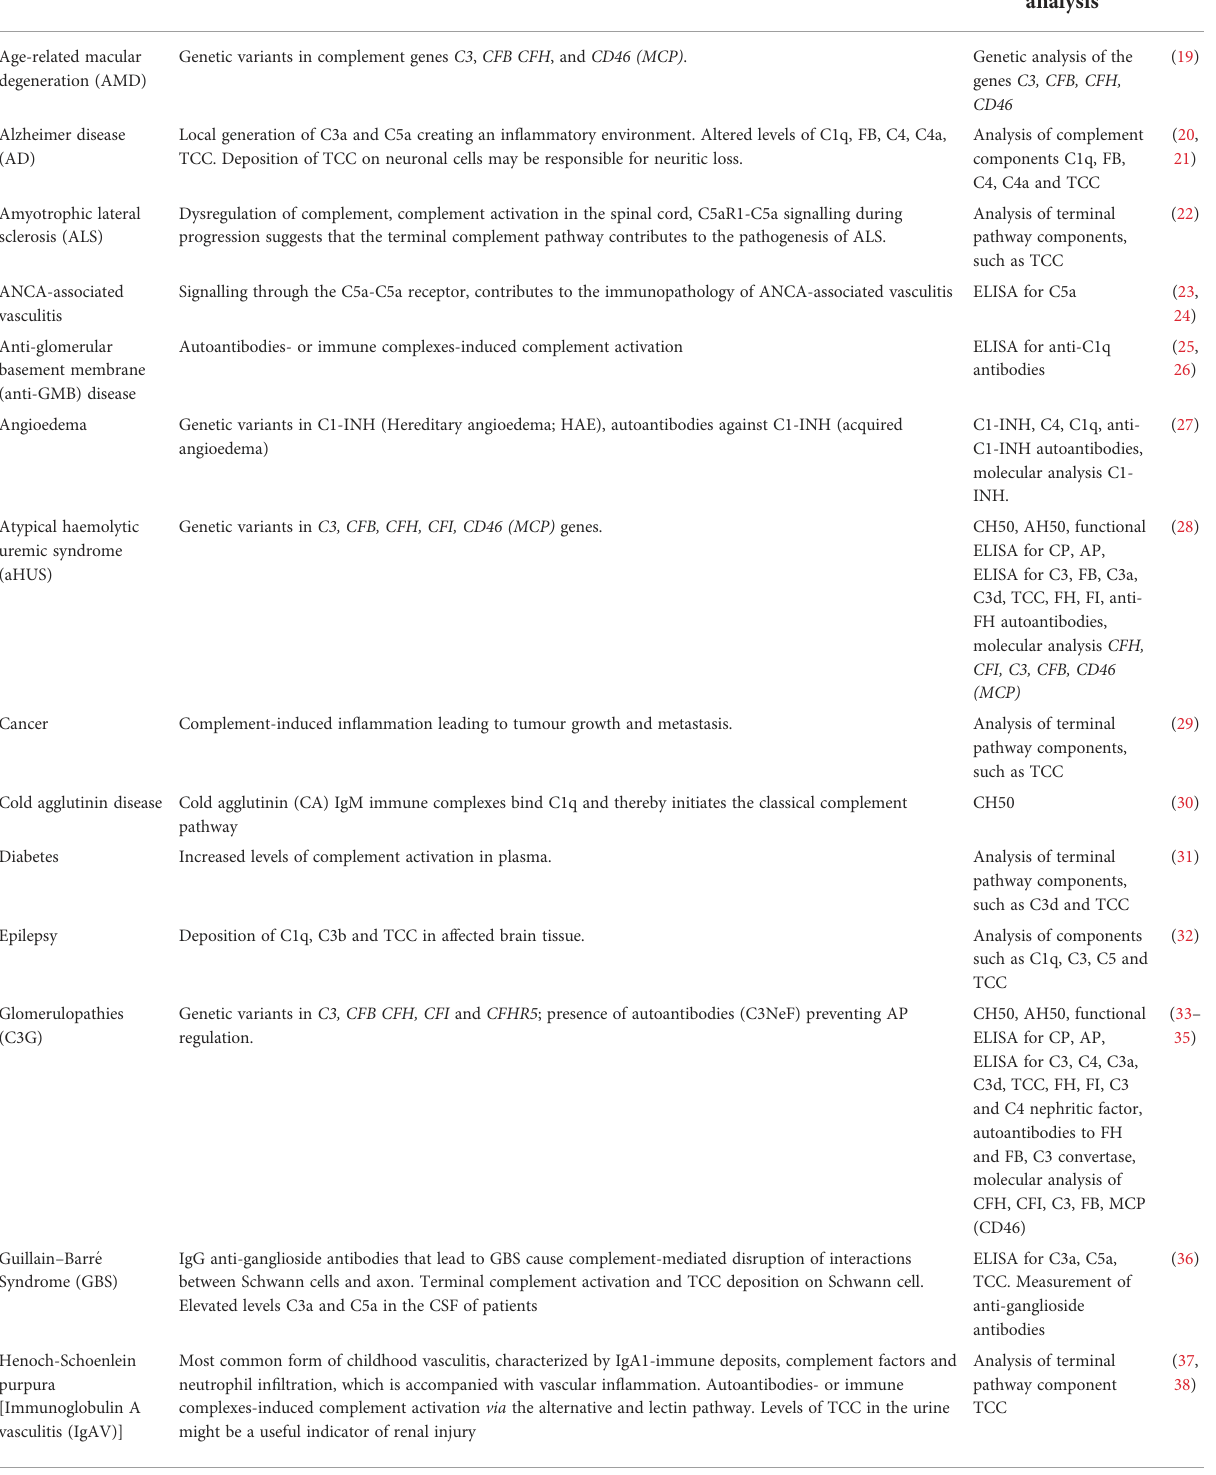
TABLE 1 Overview of complement-related diseases.